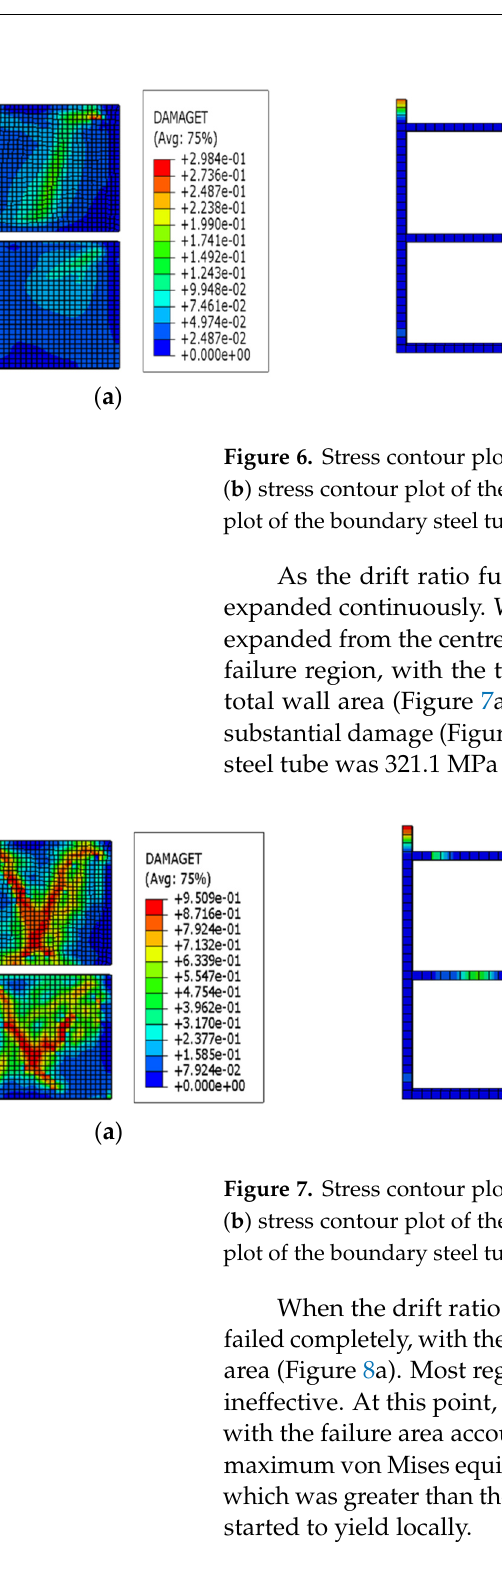
Figure 7. Stress contour plots at a drift ratio of 1/200. ( a ) Stress contour plot of the wall concrete; ( b ) stress contour plot of the concrete in the boundary steel tube; and ( c ) von Mises stress contour plot of the boundary steel tube.